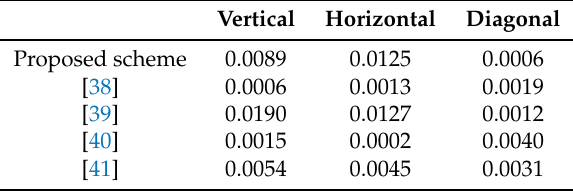
Table 2. Correlation coefficients of adjacent pixel pairs in the encrypted Lena image for different cryptosystems.